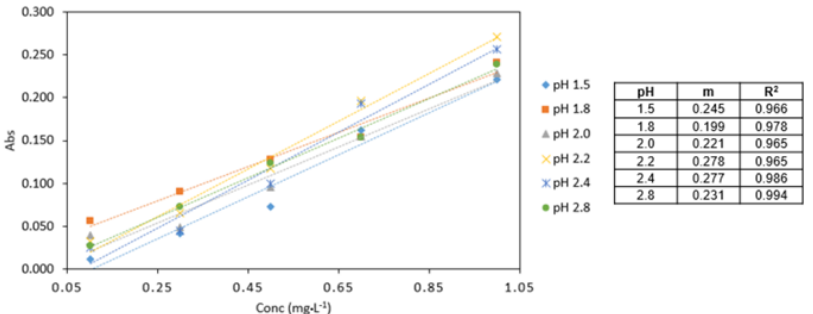
· L − 1 ) analysed at various pH conditions (pH 1.5, 1.8, 2.0, 2.2, Figure 4. Figure 4. Comparison of Cr VI (0.1–1 mg